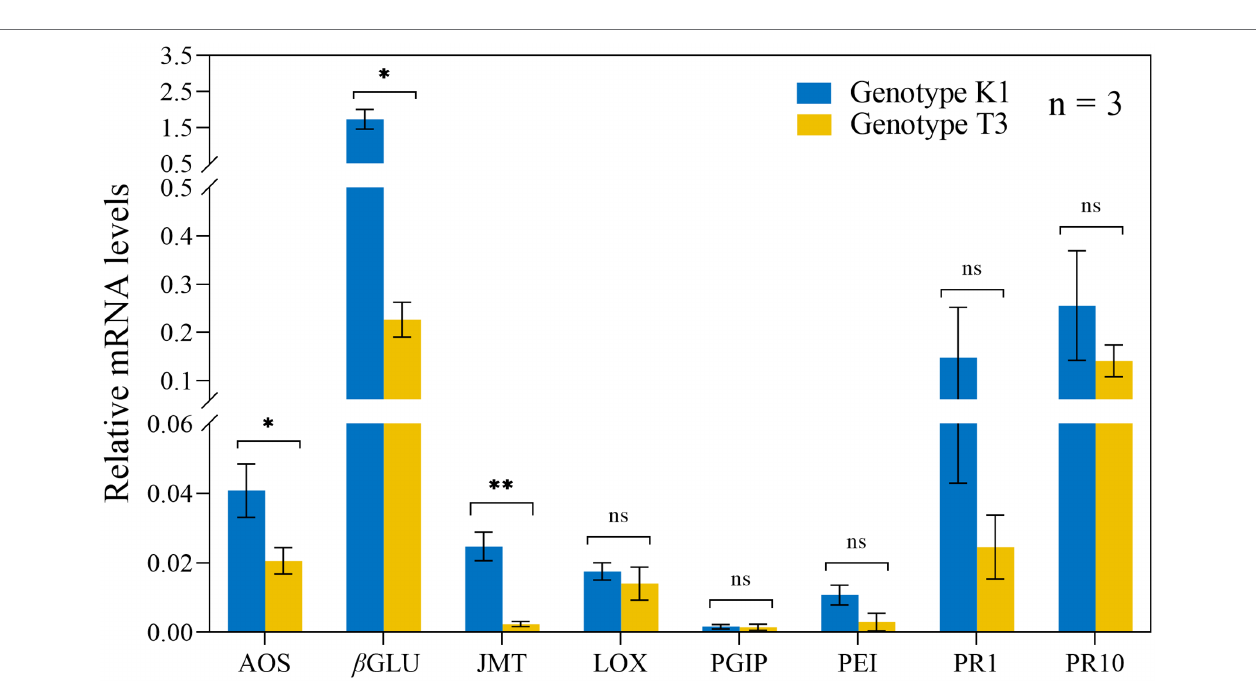
( RBOHA ), and SUPEROXIDE DISMUTASE ( SOD ) isoforms were observed between the genotypes ( Figure 6 ). Also, the expression of CATALASE ( CAT ) and PEROXIDASE ( POD ), which catalyze the conversion of H 2 O 2 to H 2 O and O 2 did not differ significantly between the two genotypes ( Figure 6 ).